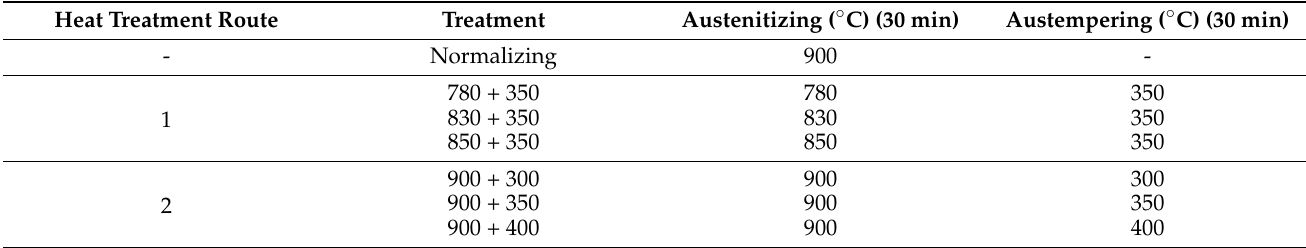
Table 2. Scheduled heat